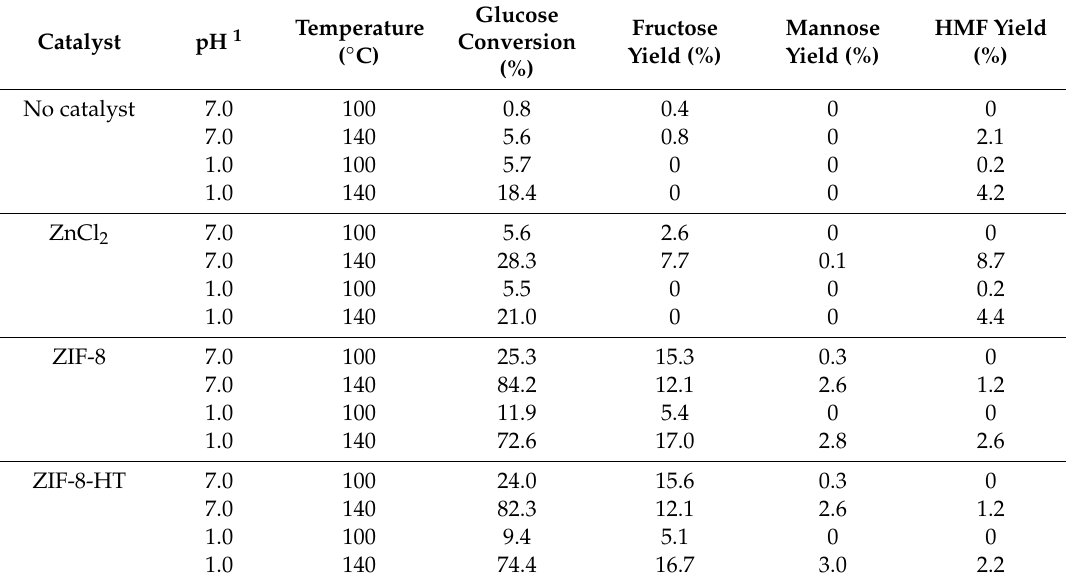
Table 3. Catalytic activity results under varying reaction conditions, with a 10 wt.% glucose aqueous stock